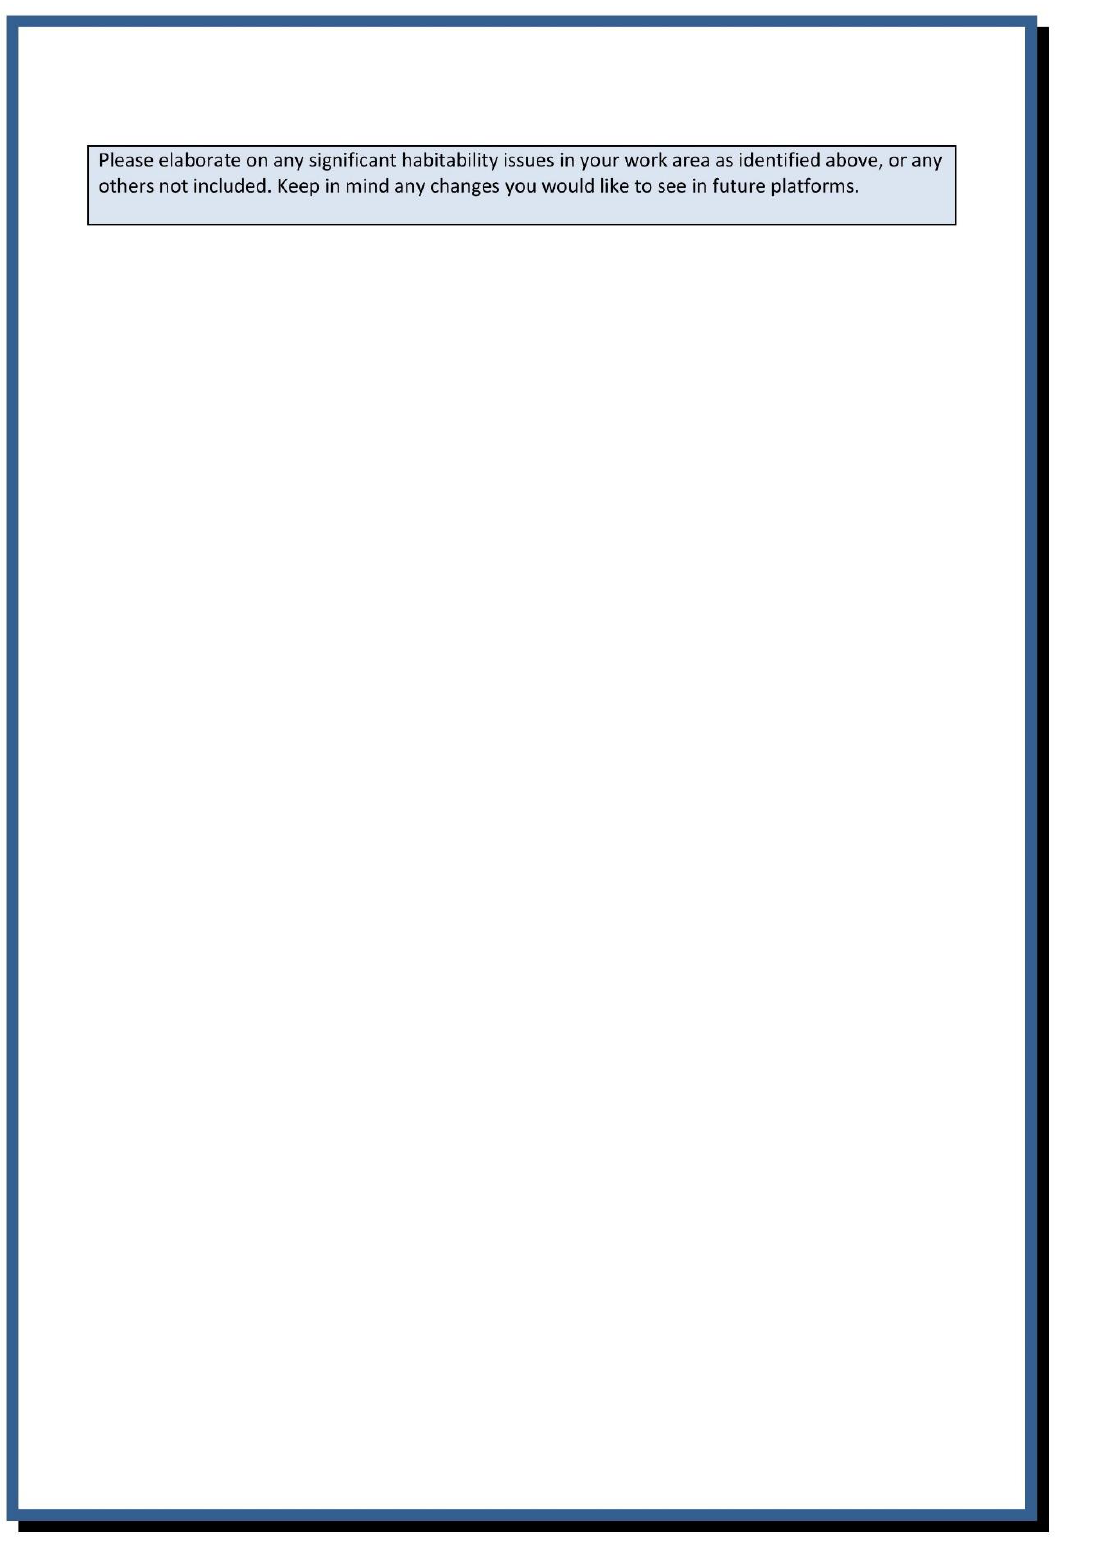
Figure A5. The Submarine Habitability Assessment Questionnaire (continued).